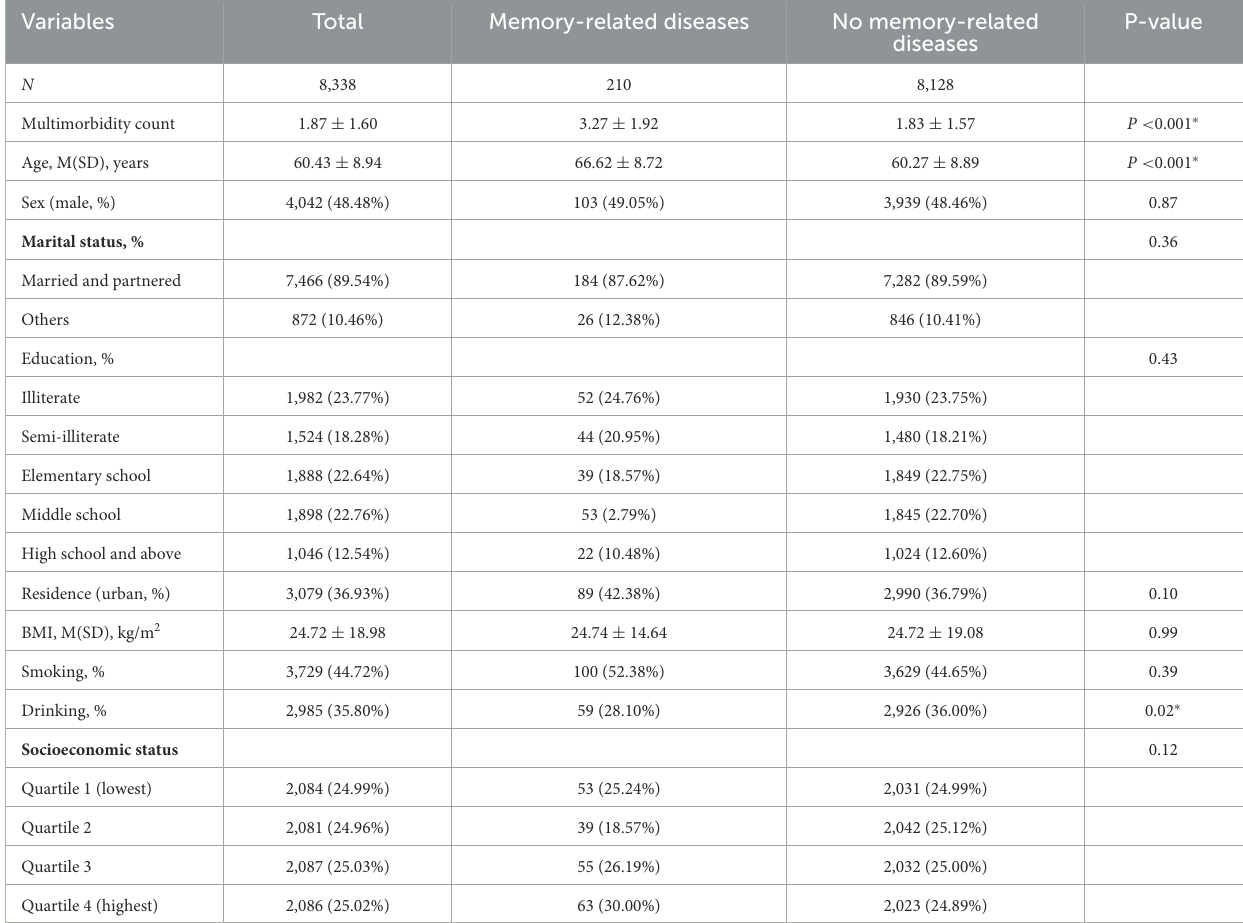
TABLE 1 Baseline characteristics of participants in the cross-sectional